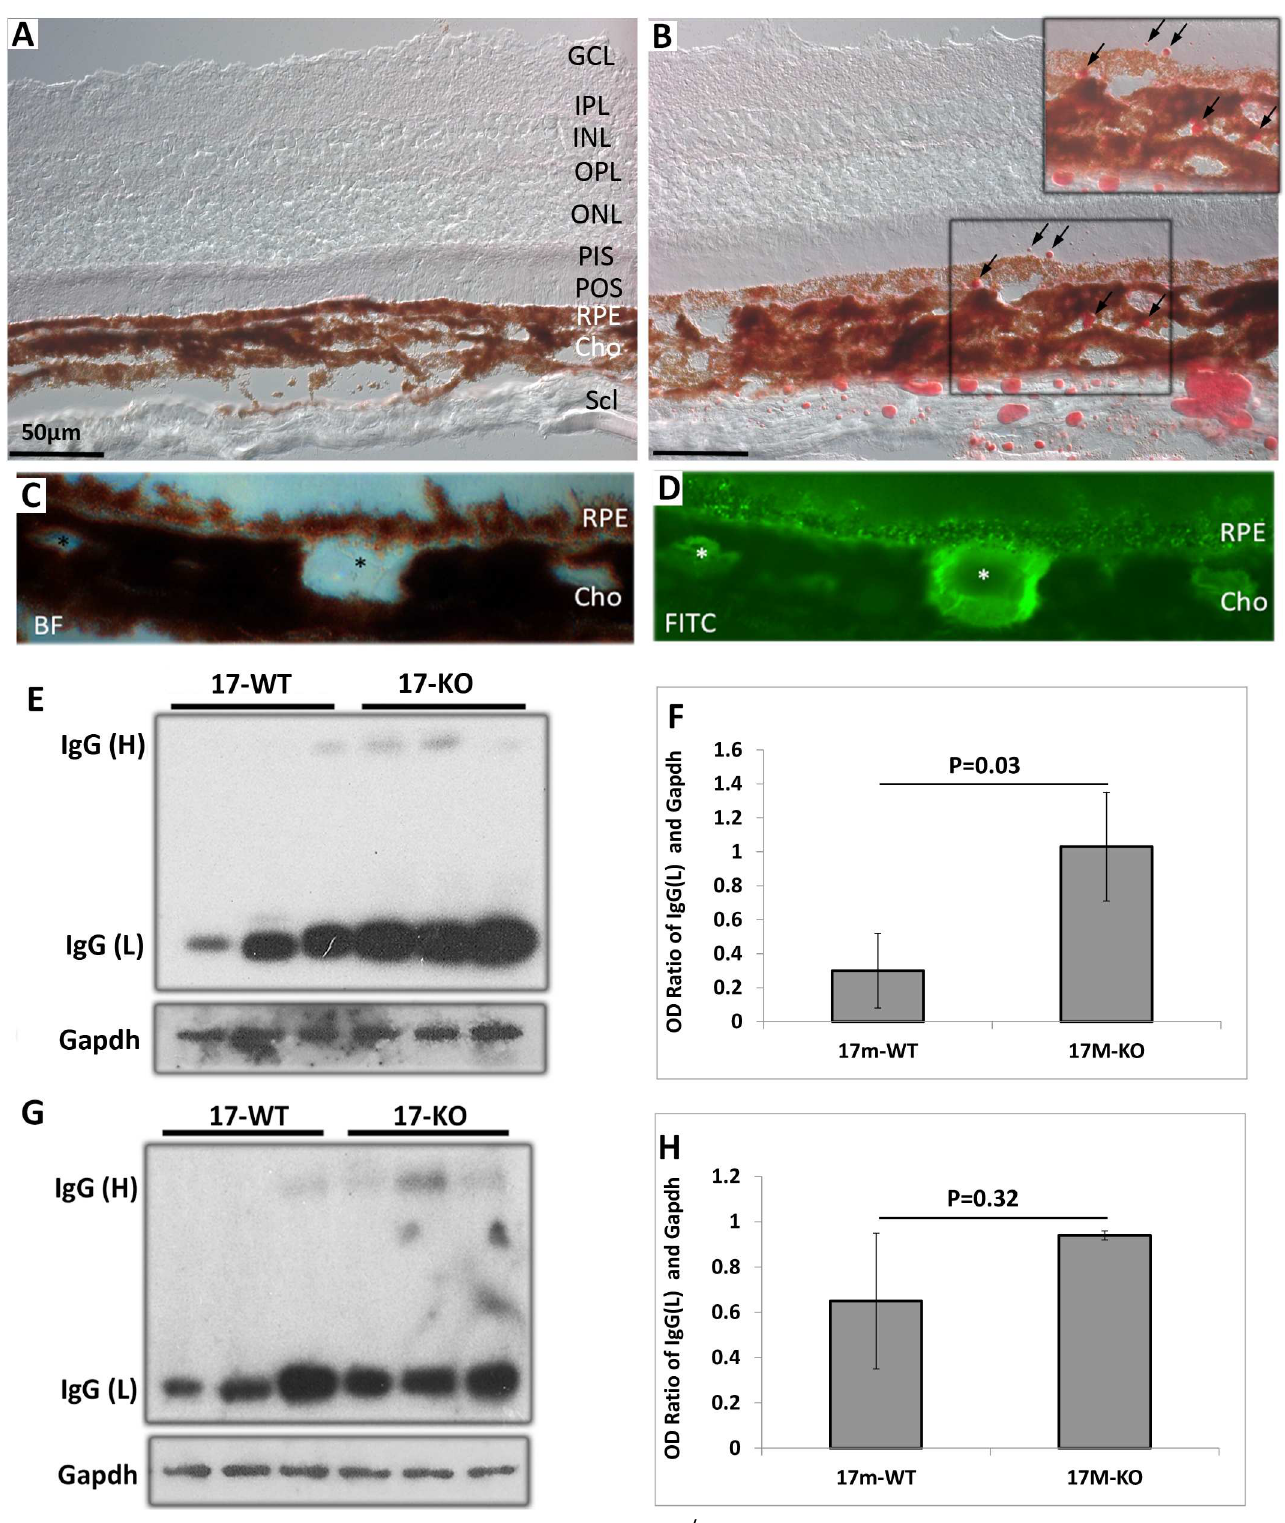
Fig 5. lipid droplets, lipofuscin granules, and increased IgG in aged Cxcr5 -/- mice. 17-month-old C57BL/6WT mice and Cxcr5 KO mice were used. ( A & B ) Oil Red O staining of the WT mice ( A ) and the KO mice ( B ). Arrrows ( B ) indicatedlipid dropletsin sub-retinalspace, RPE, and choroid. ( C and D ) Bright-field micrographand lipofuscingranulesin RPE and choroiod.BF: bright field channel. FITC: fluorescinchannel. ( E and G ) WB